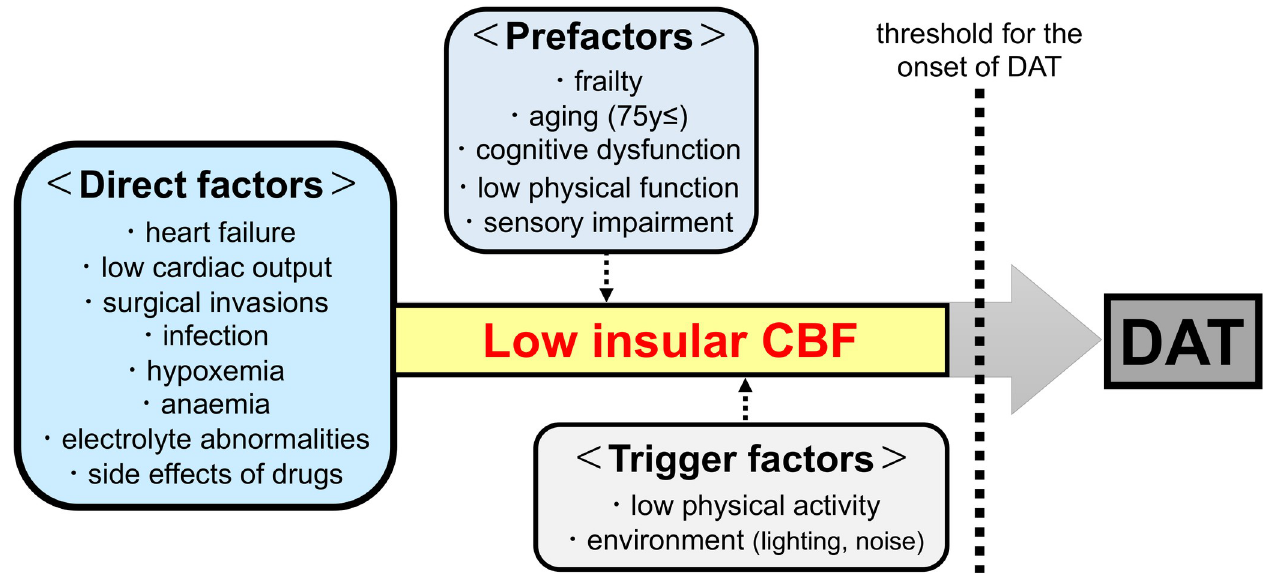
Fig 4. Multifactorial nature of DAT and possible involvement of preoperative CBF in the insula. Significant (P > 0.10) factors that contribute the onset of DAT in the present study are emphasized as red-front. Abbreviations: CBF, cerebral blood flow; DAT, delirium after transcatheter aortic valve implantation.